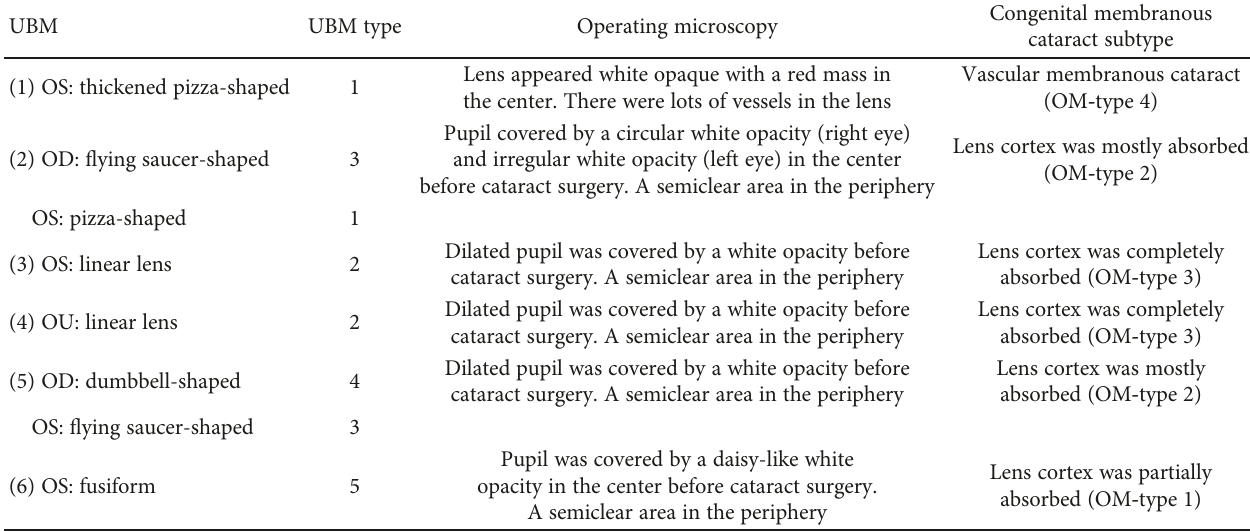
Table 3: Clinical characteristics of cataract morphology observed by UBM and operating microscopic examination by patient case.